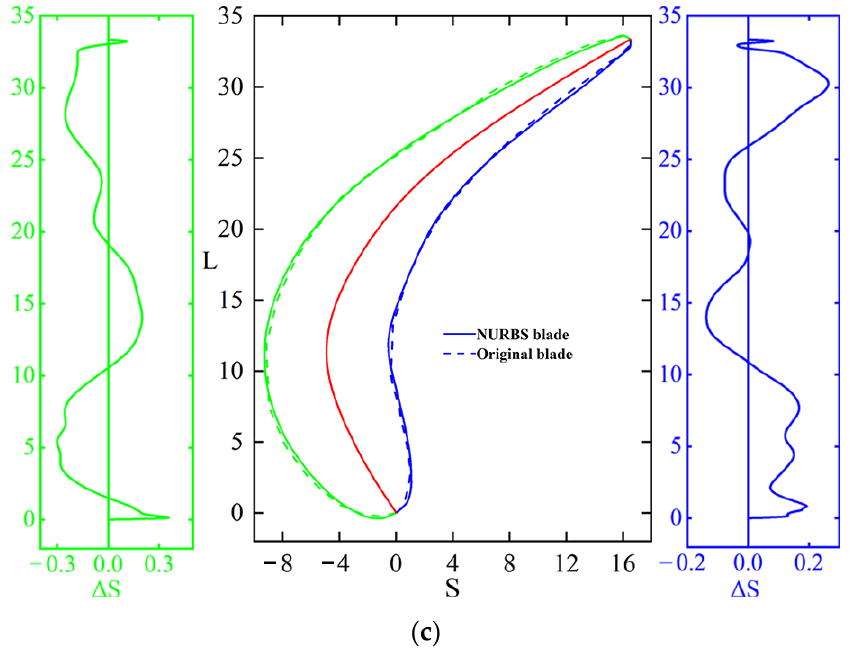
Figure 5. 2D blade profile construction results of hydrodynamic torque converter ( a ) turbine blade, ( b ) pump blade, ( c ) stator blade (the green line on both sides is the fitting error distribution of suction side, the blue line is the fitting error distribution of pressure side, and the middle part is the comparison of cascade modeling results).